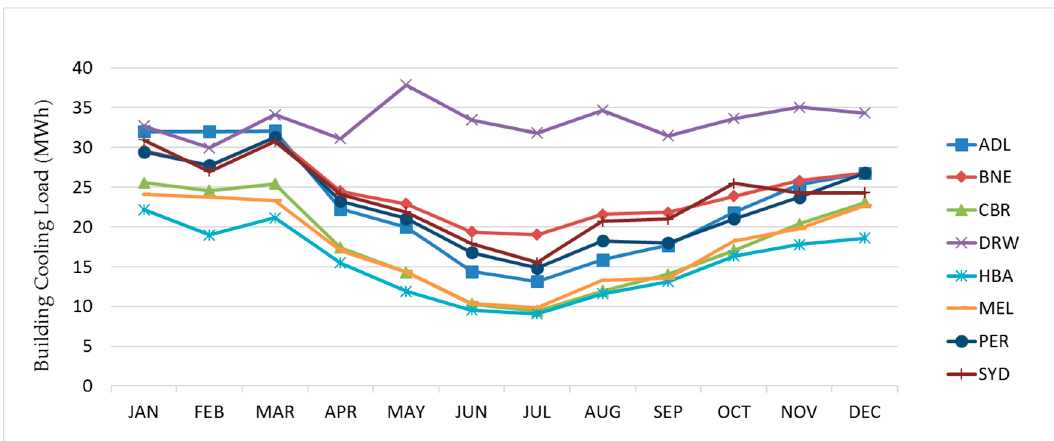
Figure 11. Monthly building heating load.